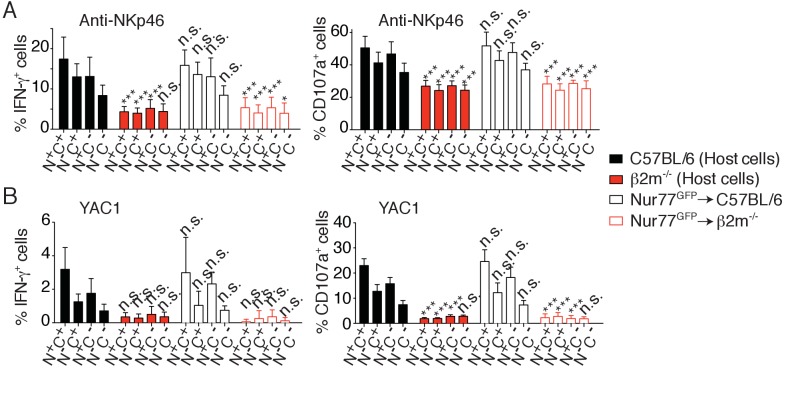
Percentage (mean +SD) of IFN-γ+ or CD107a+ cells among splenic host or transferred NK cells of the indicated subset following 4 hr stimulation with (A) coated anti-NKp46 or (B) YAC-1 cells.The experiment was done 3 days after the transfer (n = 6 mice of each genotype in two independent experiments, two-way ANOVA comparing each subset to its counterpart in C57BL/6 mice, *p<0.05, ***p<0.001, n.s. non significant).